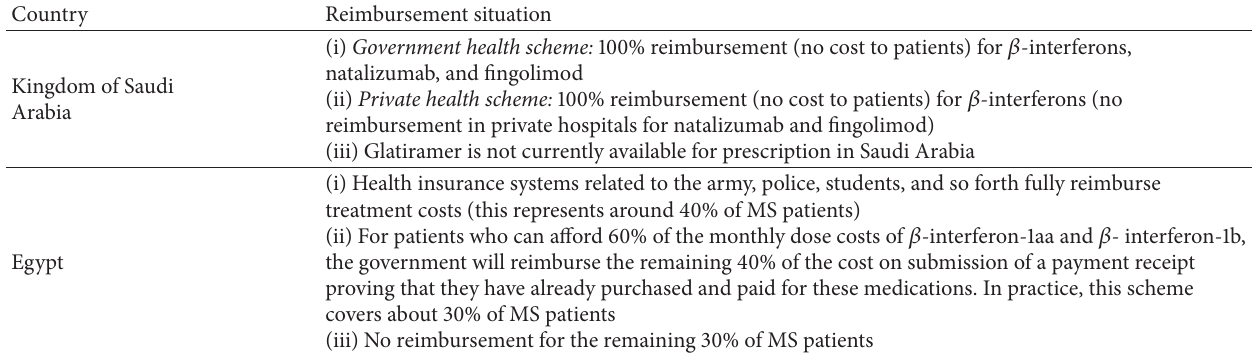
Table 2: Examples of reimbursement practices in two Middle Eastern